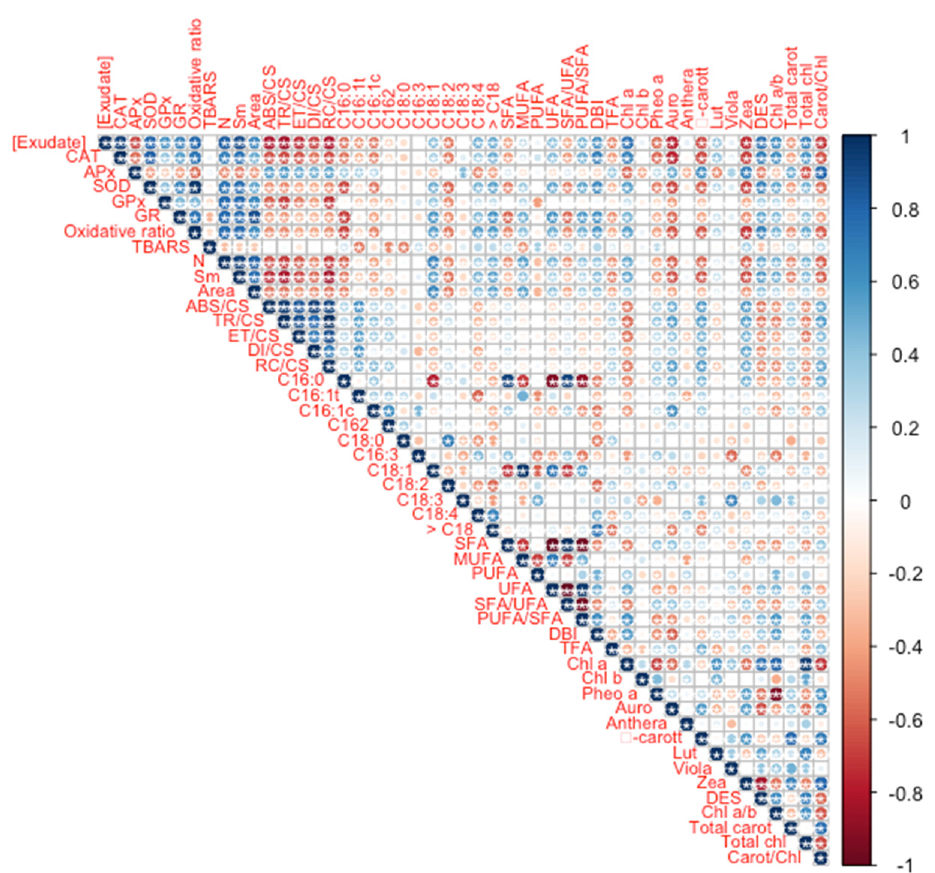
Figure 7. Thellungiella halophila leaf oxidative stress biomarkers, fatty acid and pigment profiles Spearman correlations with the Asparagopsis armata exudate at the proposed target concentrations at the end of the trial period (N = 5 per treatment; asterisks denote significant correlations at p < 0.05). Analysing each set of traits within a multivariate analysis approach, it is possible to depict which metabolic groups can be used as biomarker profiles of plant exposure to the A. armata exudate cocktail (Figure 8). Applying this approach to the Kautsky curve dataset (Figure 8A), it is possible to observe that this approach can efficiently (78.9% correct classification efficiency) distinguish the plants exposed to the different